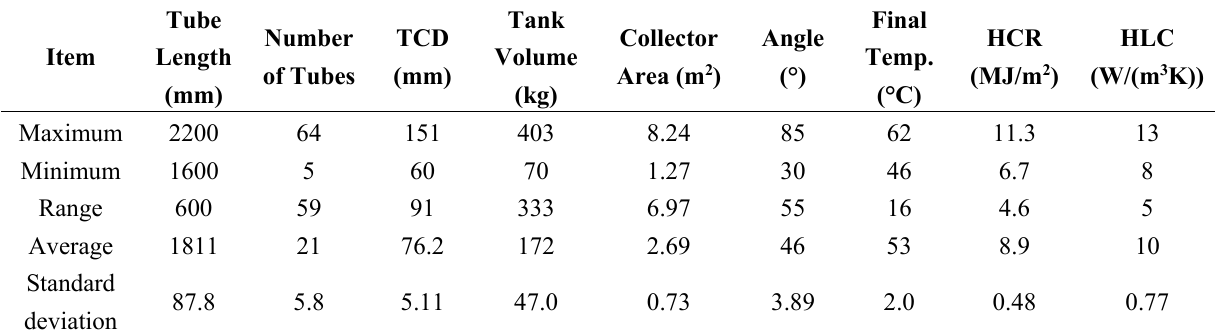
Table 2. Descriptive statistic of the variables for 915 samples of in service water-in-glass evacuated tube solar water